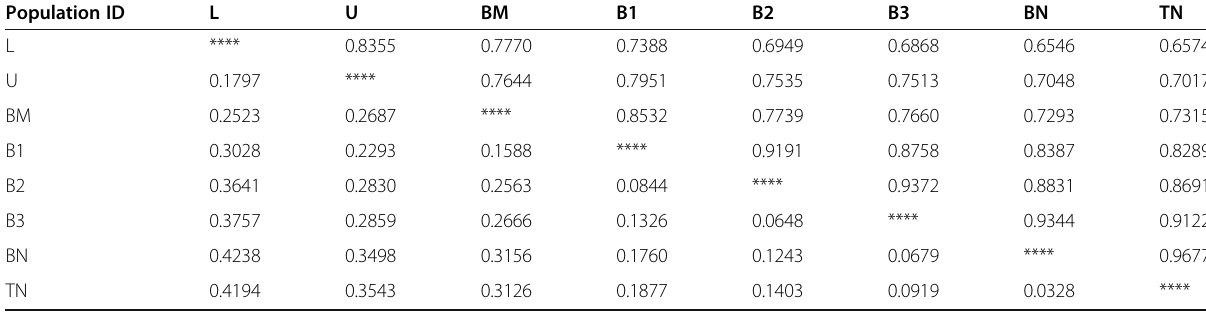
Table. 7 Nei ’ s unbiased measures of genetic identity and genetic distance among I . griffithii populations Population ID